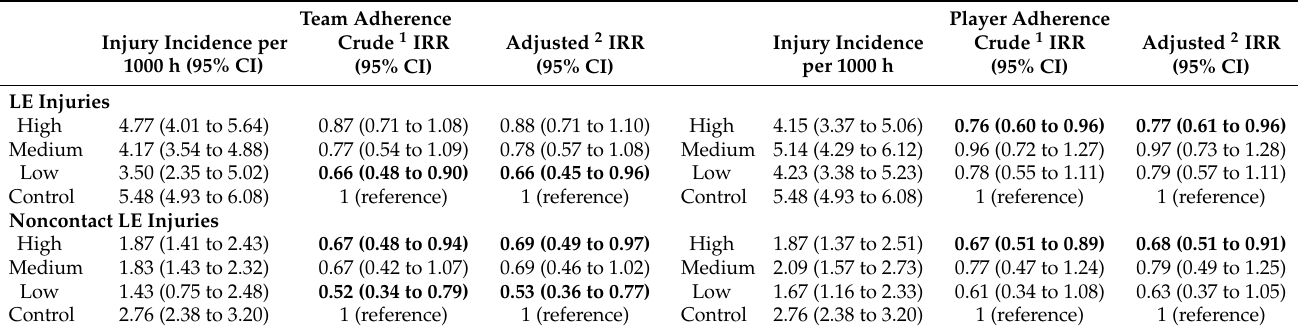
Table 2. Negative binomial regression analysis of acute lower extremity (LE) injury incidence between intervention adherence groups compared to control group.